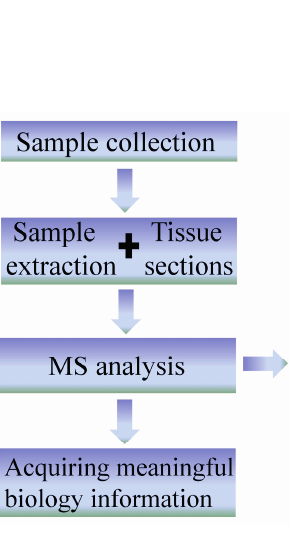
Figure 1. A flowchart of the study of lipidomics (ST,